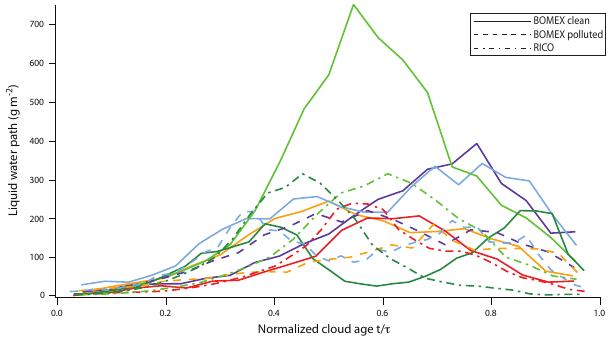
Figure 12. Time series of liquid water path. Liquid water path is the cloud-integrated LWC divided by maximum cross-sectional